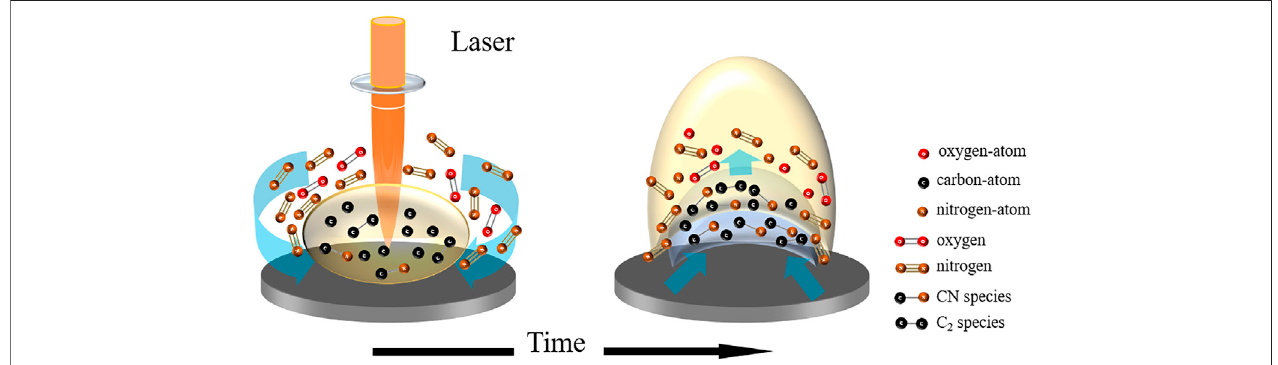
FIGURE2| FormationroutesofCNandC 2 molecularemissions.Laserablatesample,atomizingcarbon-atomandnitrogen-atom,fragmentingCNandC 2 species fromthesample,andatomizingnitrogen-atomandoxygen-atomfromambientgas.Speciesfromthesampleandsurroundingscombiningnewmolecularspeciesinthe